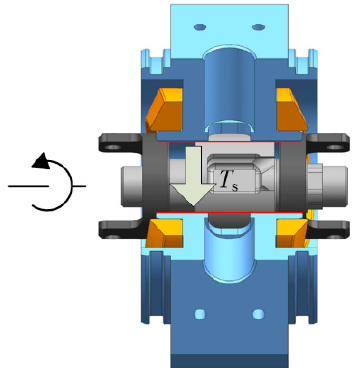
Figure 10. Resistance torque caused by the shearing flow during rotation.